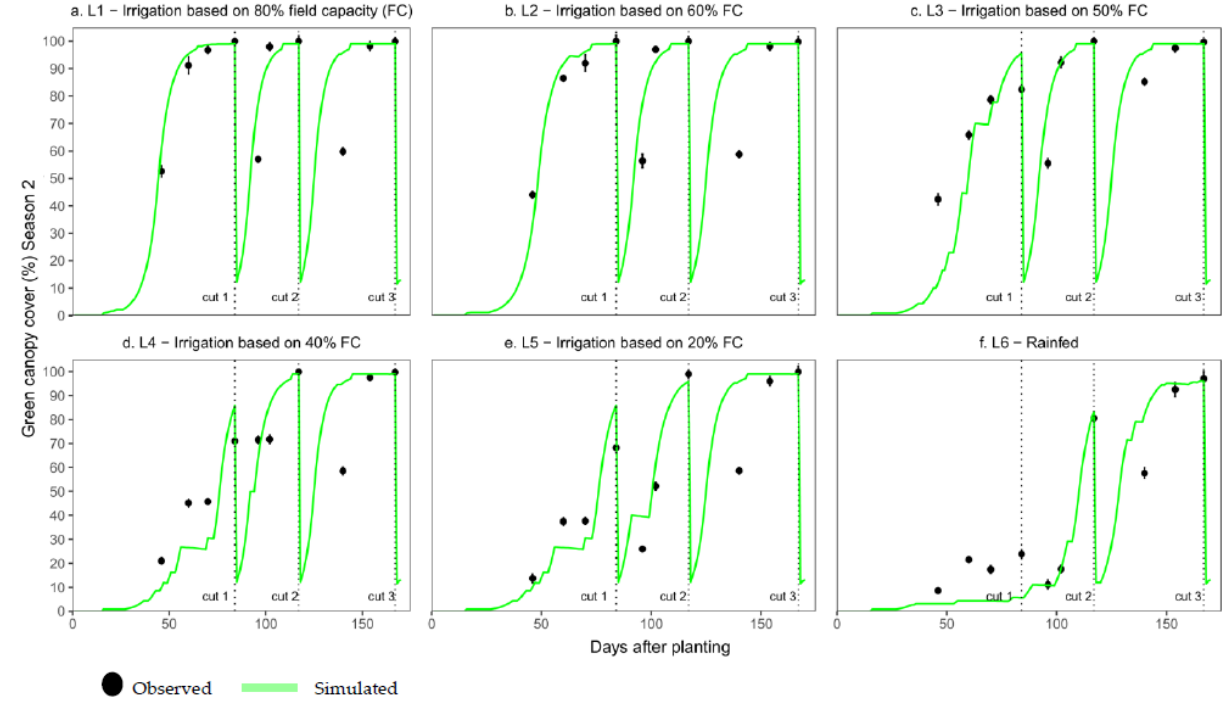
Figure 7. Observed and simulated canopy cover (CC) under different irrigation treatments during the second growing season (2021/22) of Guinea grass ( Megathyrsus maximus cv. Agrosavia sabanera). The error bars represent standard deviations. (a). CC for the treatment L1—irrigation based on 80% field capacity (FC); (b). CC for the treatment L2—irrigation based on 60% FC; (c) CC for the treatment L3—irrigation based on 50% FC; (d) CC for the treatment L4—irrigation based on 40% FC; (e) CC for the treatment L5—irrigation based on 20% FC; (f) CC for the treatment L6—rainfed.